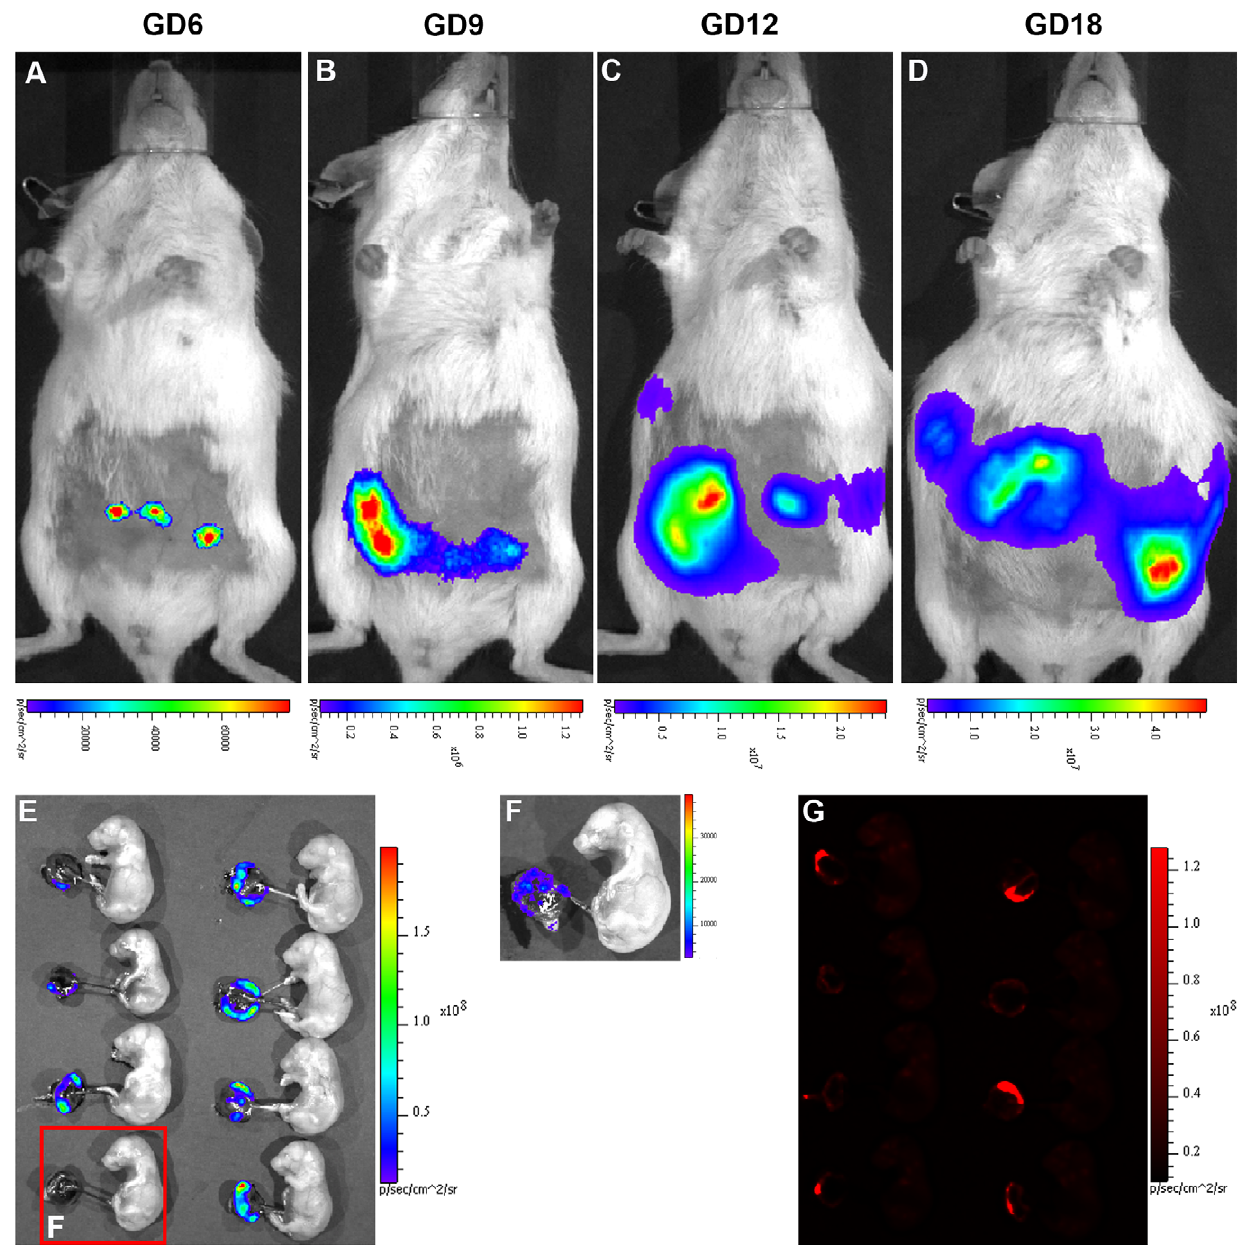
Figure 4. Wide variability in Fluc expression among placentas of the same litter despite identical conditions of viral transduction of blastocysts. A–D, BLI of Fluc expression in placentas at different stages of pregnancy; E, dramatic variations in Fluc expression among different placentas from the same litter collected on GD18; F, detection of very weak Fluc signal in a placenta (marked in E) after lowering the threshold of BLI. G, Tomato florescence images of the placentas shown in E.